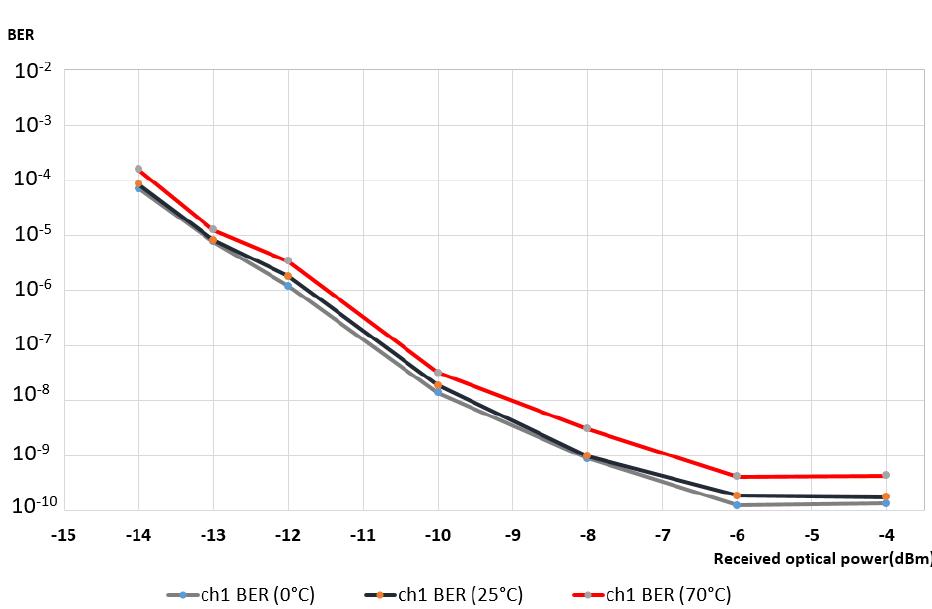
Figure 14. Optical PAM4 bit error rate (BER) curves obtained for the three different